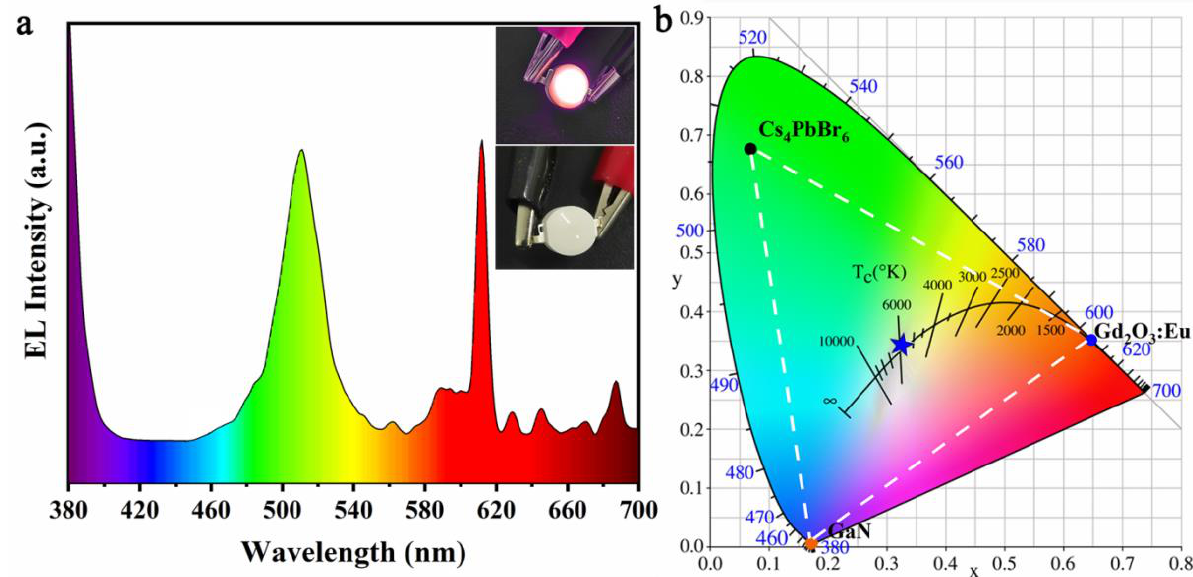
Figure 1. ( a ) EL spectrum of W-LED illustrated with photos after and without power on; ( b ) color coordinate diagram of W-LED.